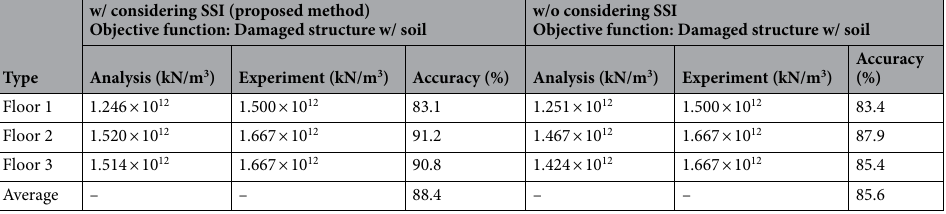
Table 6. Comparison of floor stiffness according to the FE model applied with model